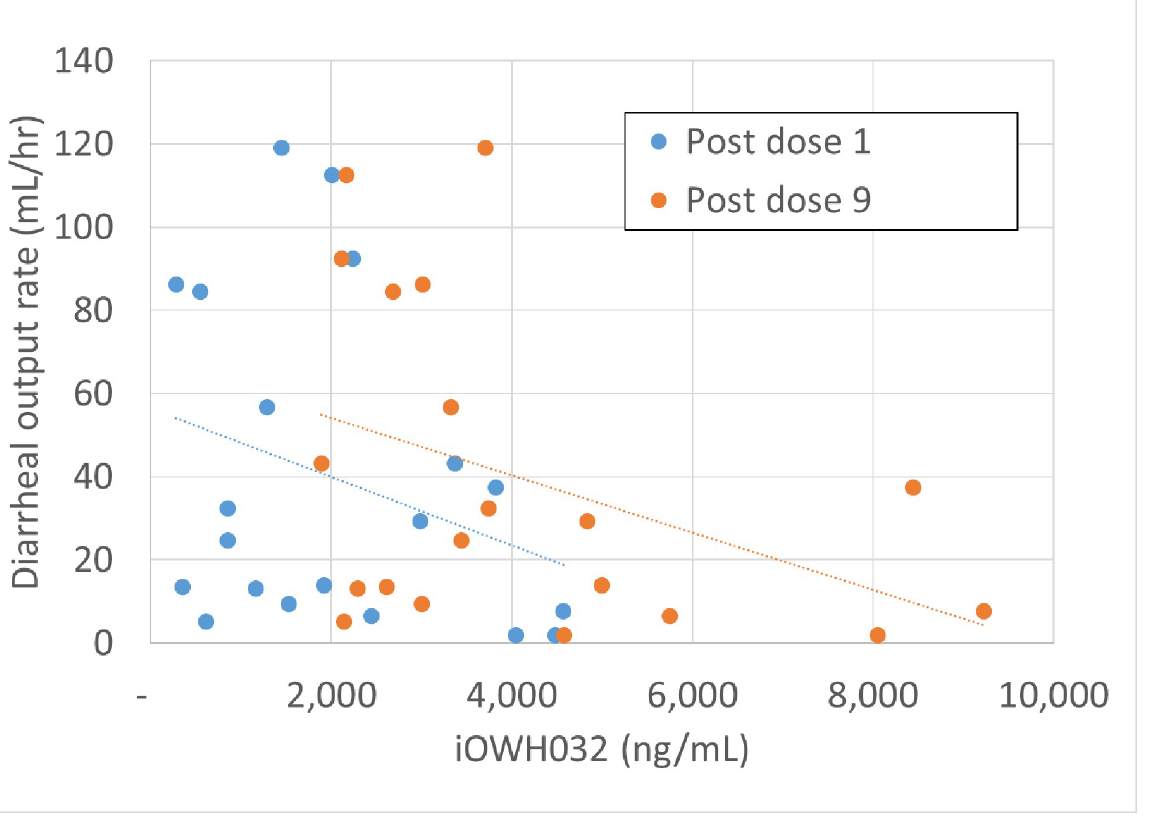
Fig 3. Scatterplot of iOWH032 plasma concentrations versus diarrheal stool output rate. Blue dots: plasma levels at 7 hours after dose 1; orange dots: plasma levels at 7 hours after dose 9. Dotted lines: linear regression plots. The Pearson correlation coefficients for these lines are – 0.2997 for post dose 1 data and –0.3937 for post dose 9